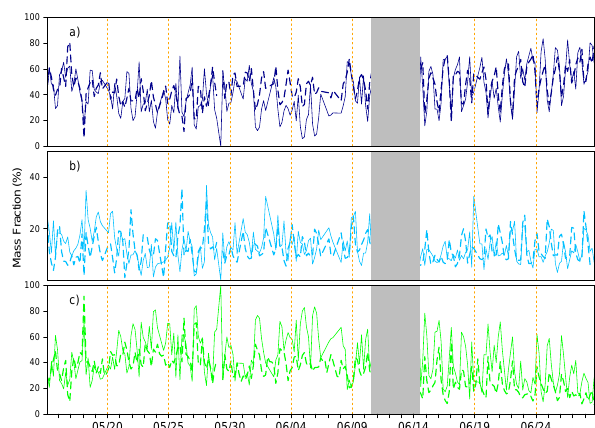
Fig. 7. Time series of the number fraction for (i) cluster I (dark blue), (ii) cluster II (light blue), and cluster III (green) particles. Time series of odd oxygen (O x , shown in panel i) and temperature (panel ii and iii) are shown for comparison.